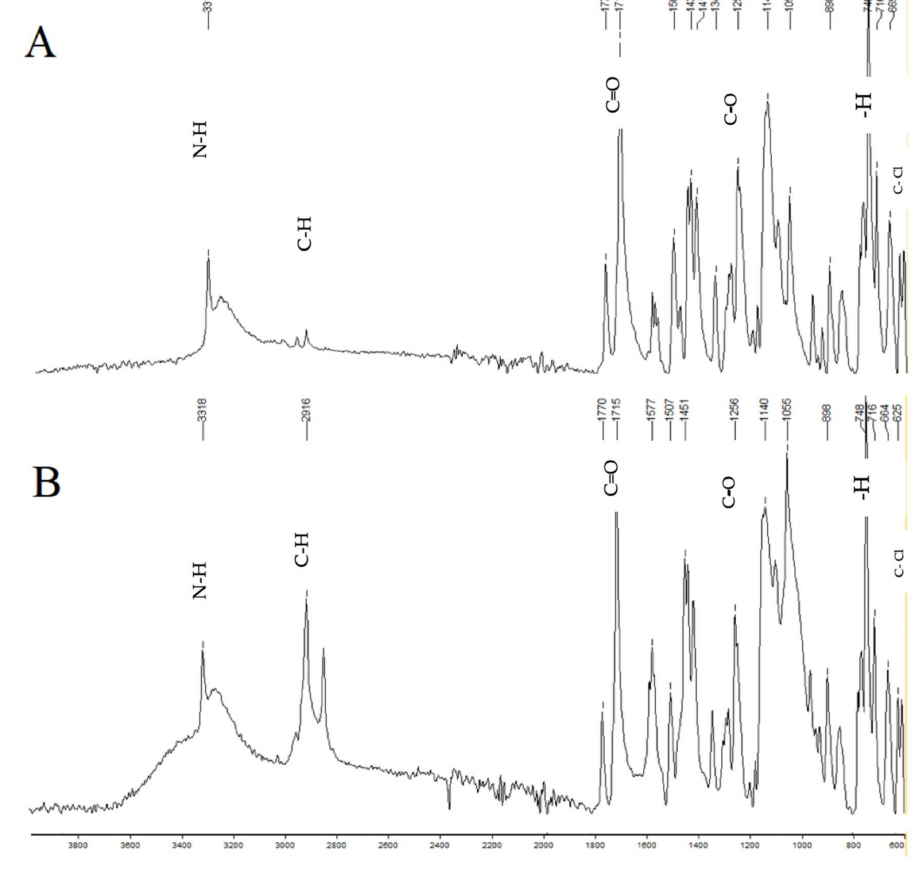
Figure 1. FTIR of aceclofenac ( A ) and press-coated tablet with HPMC E5 ( B ). The characteristic peaks of the aceclofenac spectrum are 1715, which shows C=O stretching; 1255, which shows C-O stretching; 3318, which shows N-H stretching; 2937, which shows C-H stretching; 748, which shows aromatic—H stretching; and 610, which shows C-Cl